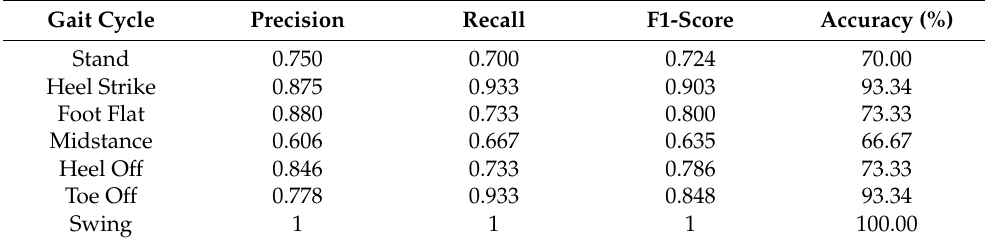
Table 1. Gait classification accuracy with k = 3.